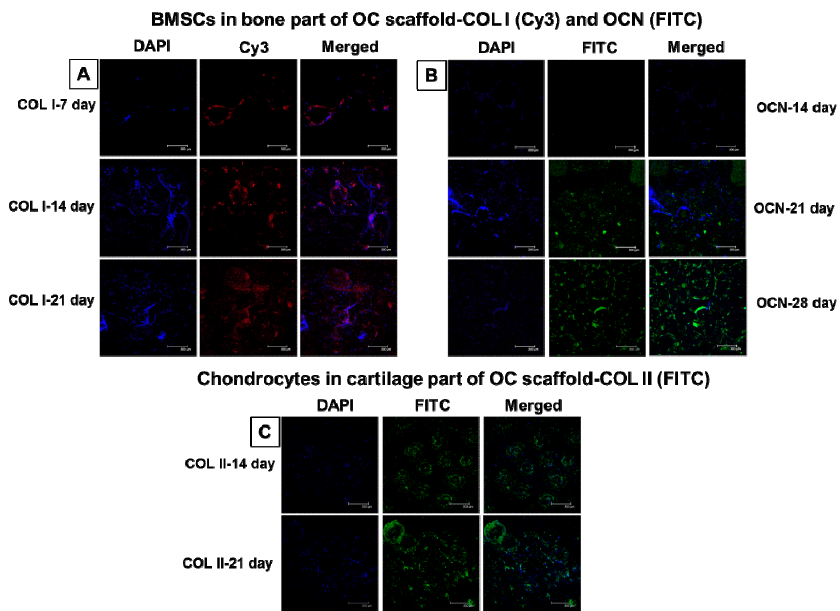
Figure 10. Immunofluorescent staining images using DAPI for cell nucleus and Cy3-conjugated antibody for type I collagen (COL I) ( A ); DAPI for cell nucleus and FITC-conjugated antibody for osteocalcin (OCN) ( B ); DAPI for cell nucleus and FITC-conjugated antibody for type II collagen (COL II) ( C ) at various durations of BMSCs-chondrocytes co-culture in OC scaffolds. Bar = 300 µm.